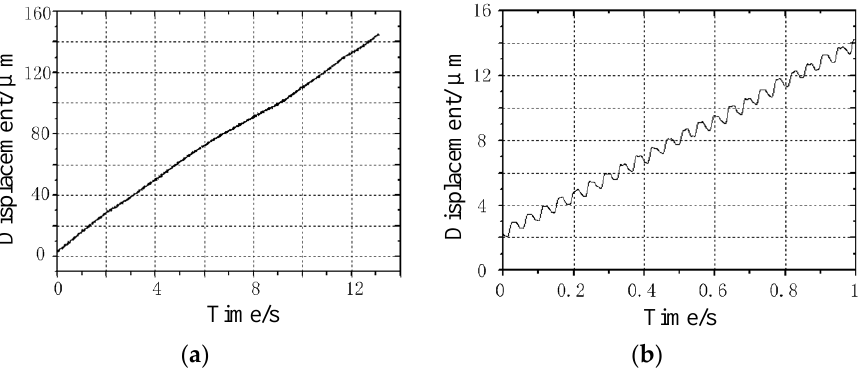
Figure 12. No-load operation curve of the prototype under the excitation frequency of 22 Hz: ( a ) travel curve of the prototype within 13 s; and ( b ) Travel curve of prototype within 1 s. During the no-load operation of the prototype, the characteristics of the